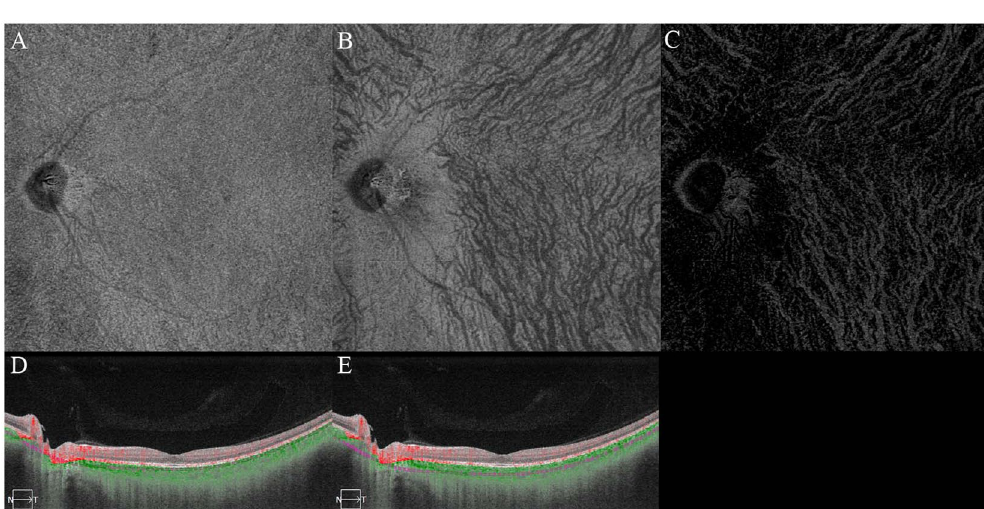
Figure 1. Case 5. Left eye of 30-year-old man. Subfoveal choroidal thickness is 290 µ m. Ratio of flow area is 27.4%. Brightness and contrast are adjusted for easier observations of these figures. ( A ) Choriocapillaris image. ( B ) Half of the choroid image. ( C ) Choroidal blood flow image after removal of the projection artifacts of choriocapillaris. ( D ) Cross sectional image with the segmentation boundaries set to the choriocapillaris. ( E ) Cross sectional image with the segmentation boundaries set to one-half of the